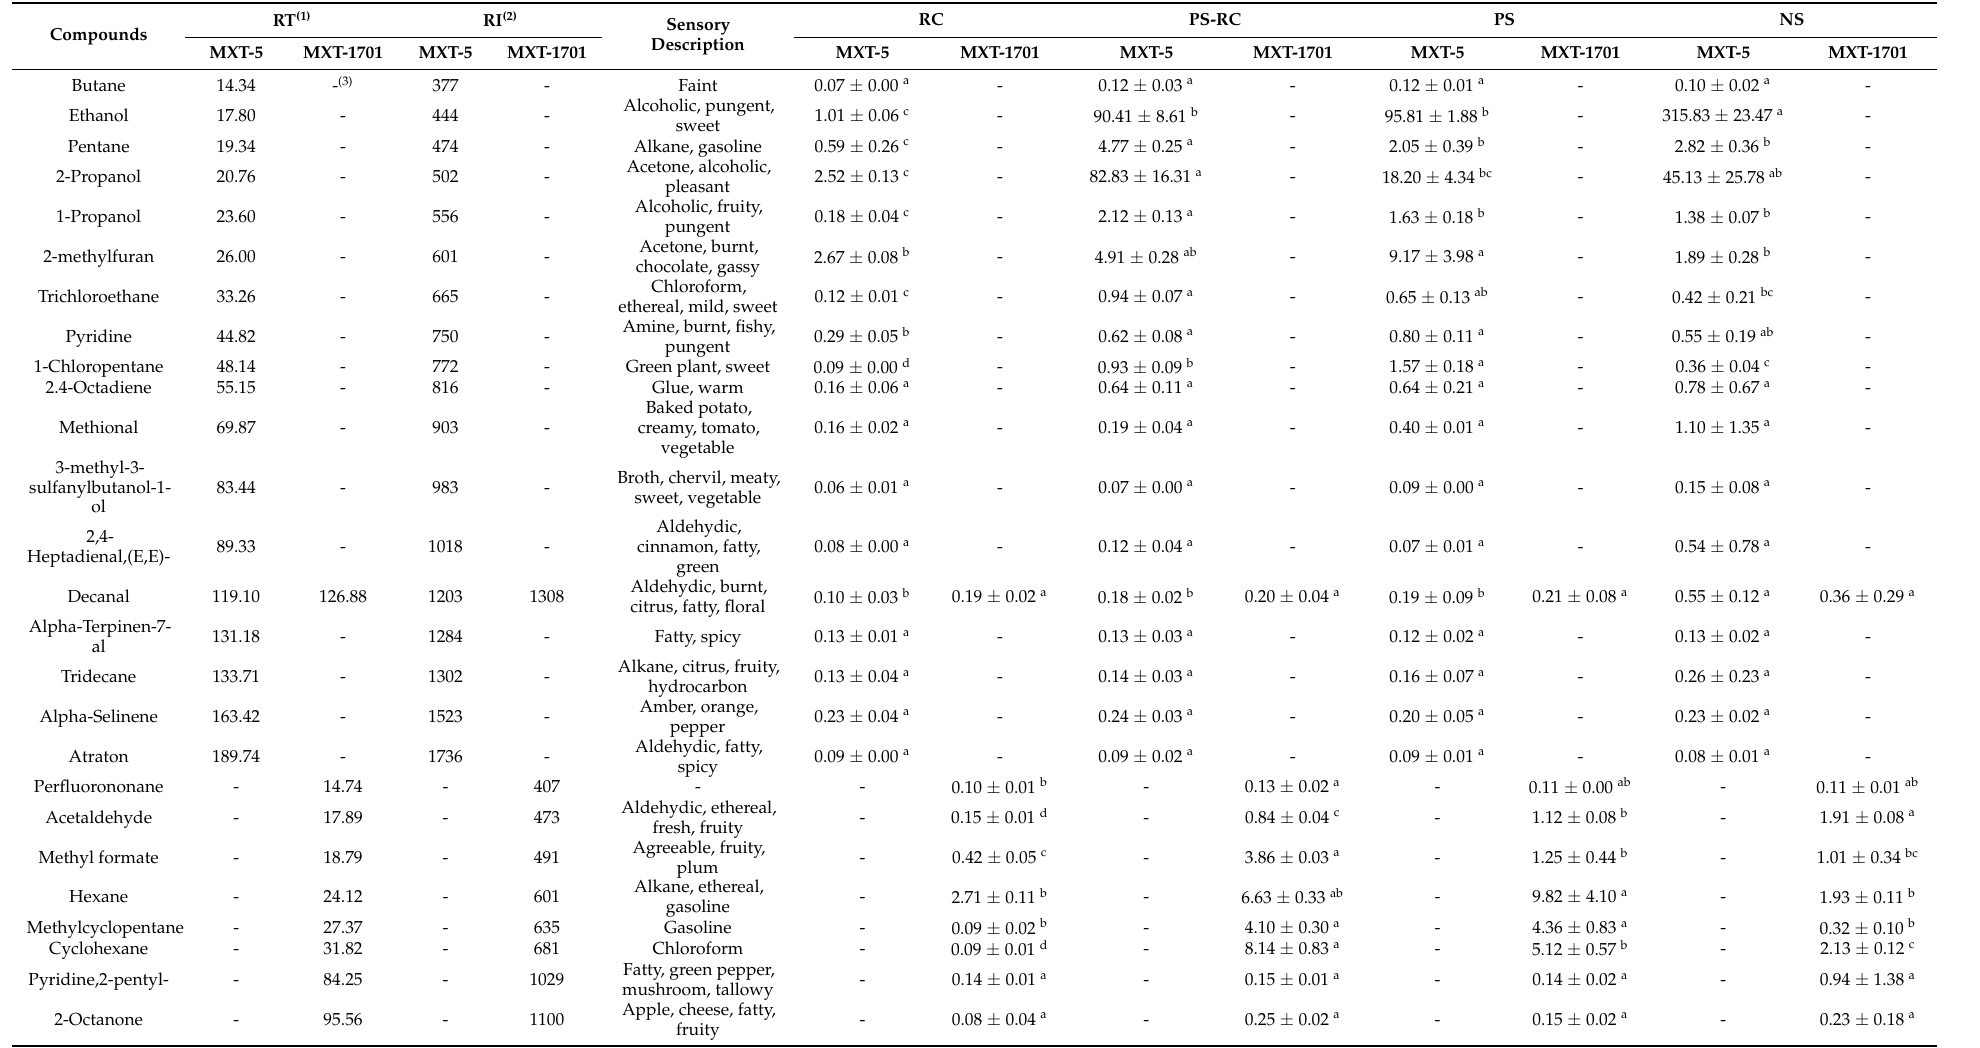
Table 5. Relative volatile compounds of snow crab leg meat and commercial imitation crab sticks as detected and quantified using an electronic